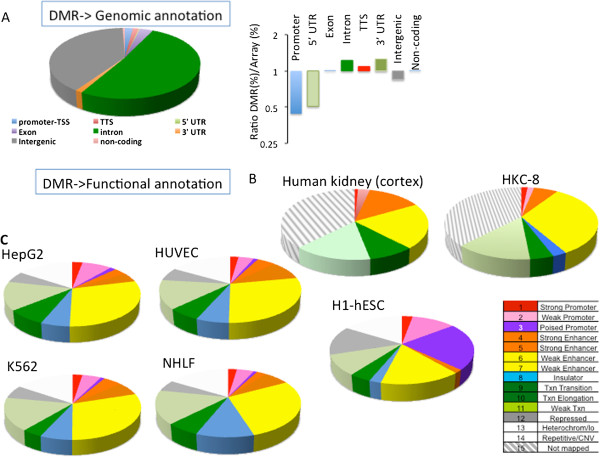
Chronic kidney disease differentially methylated regions are localized to kidney-specific enhancer regions. (A) RefSeq annotation of the DMRs. Relative enrichment ratio of the DMRs compared with the representation of the different elements on the methylation microarray. TSS, transcription start site; TTS, transcription termination site. (B) DMRs overlap with regulatory element (chromatin state) annotation maps of renal tubule epithelial cells (HKC8) and adult kidney cortex, indicating that most differentially methylated cytosines are localized to enhancer (yellow and orange) regions in kidney epithelial cells. The color code annotation of the chromatin state map is provided bottom right. (C) Chromatin annotation of the DMRs in five different ENCODE cell lines (H1, human embryonic stem cells; HepG2, hepatocytes; HUVEC, endothelial cells; K562, erythroid cells; NHLF, human lung fibroblasts).